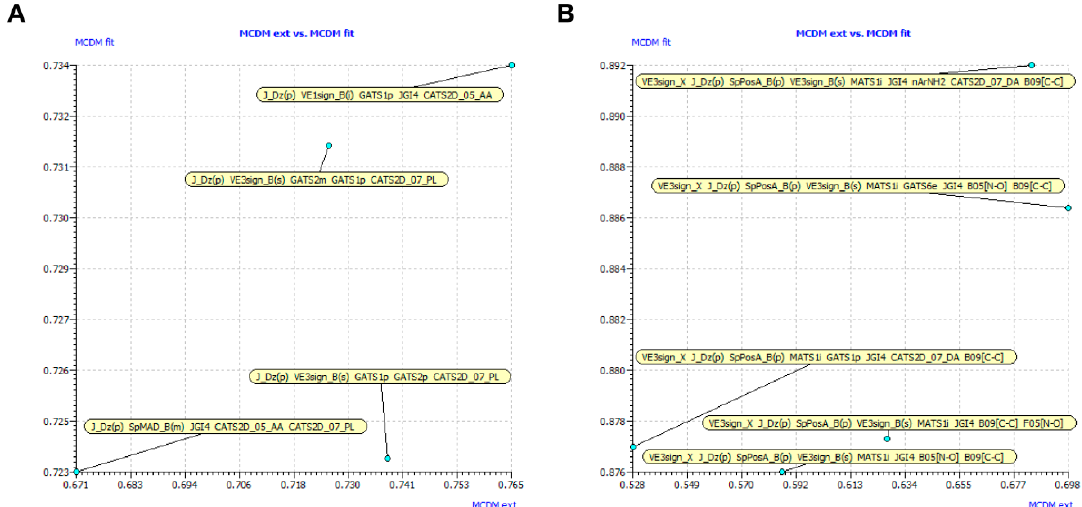
Figure 1. Multi-Criteria Decision Making (MCDM) graphs of the generated models based on 103 ( A ) and 84 ( B ) base analogs.